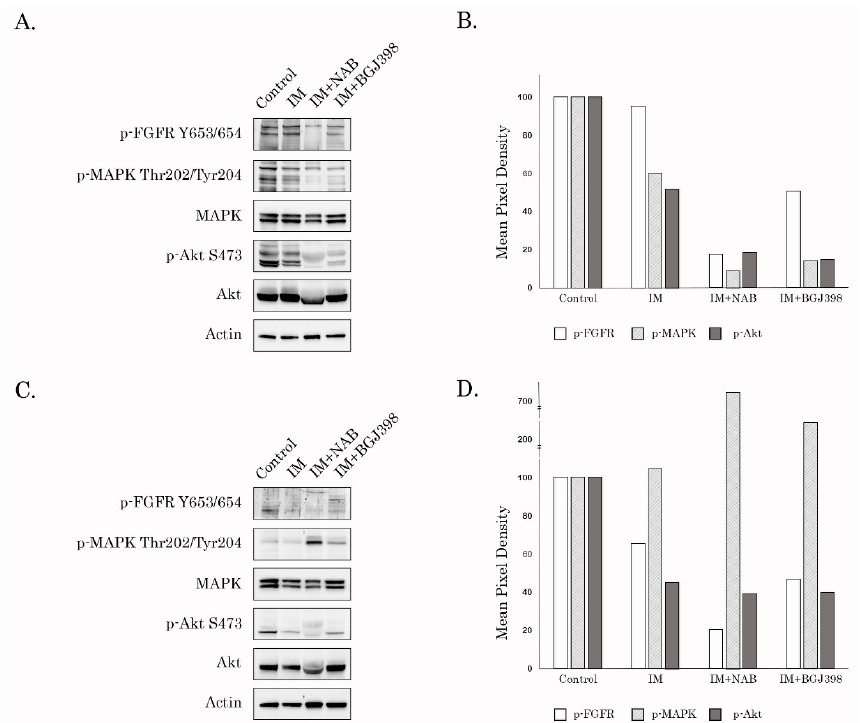
Figure 3. Inhibition of FGF-signaling deregulates AKT- and MAPK-phosphorylation in IM-resistant GISTs. ( A ) Anti-FGF2 neutralizing Abs (20 µ g / mL) and BGJ398 (1 µ mol / L) abrogate IM-induced activation of GIST T-1R cells. Cells were treated with IM (1 µ mol / L) in the presence of anti-FGF-2 Abs for 72 h and subjected to the immunoblot analysis for total and phosphorylated forms of FGFR, MAPK, and AKT. Actin staining was used to show the comparable amounts of protein loaded into each sample. ( B ) Quantification by mean pixel density revealed that the phosphorylated proteins are dysregulated in GIST T-1R after the inhibition of FGFR signaling. ( C ) The impact of anti-FGF2 neutralizing Abs (20 µ g / mL) and BGJ398 on IM-induced activation of GIST 430 cells. Cells were treated with IM (1 µ mol / L) in the presence of anti-FGF-2 Abs for 72 h and subjected to immunoblot analysis for total and phosphorylated forms of FGFR, MAPK, and AKT. Actin staining was used to show the comparable amounts of protein loaded into each sample. ( D ) Quantification by mean pixel density revealed that the phosphorylated proteins are dysregulated in GIST 430 after the inhibition of FGFR signaling. The whole western blot of Figure 3A,C are in Figures S7 and